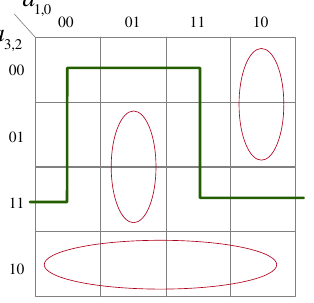
FIG. 3. The Karnaugh map of the A = 4 base case for recur- sive H2GC construction. The sequence is illustrated with a solid line and passes through eight codes. The remaining eight unused codes are covered by a 2-local term on the bottom, and a pair of 3-local terms indicated by vertical ovals.